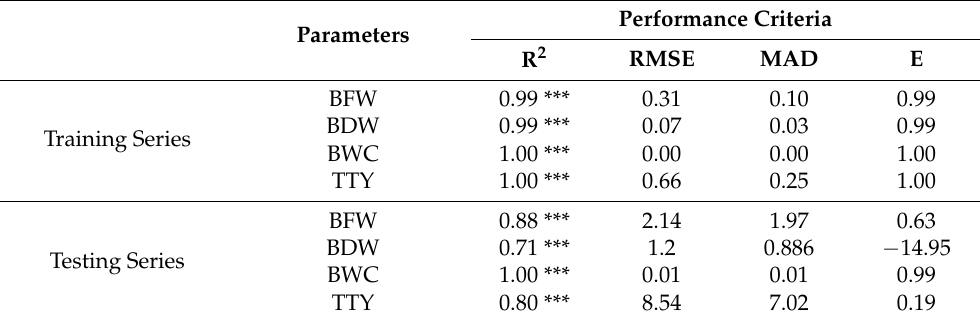
Table 5. Performance Criteria of Adaptive Neuro-Fuzzy Inference System (ANFIS) models for measured parameters including Biomass Fresh Weight (BFW), Biomass DRY Weight (BDW), biomass Water Content (CWC), and Total Tuber YIELD (TTY) Across All Data (n = 48).